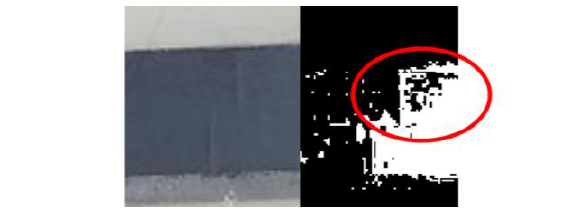
Figure 5. Result of irregular passes of the machinery (true colour image – left; binary image – right) A fact that could be confirmed in the calculated binary image (highlighted in figure 5 by a red circle). The respective pixels of that highlighted area were not detected as compacted and therefore a pixel value (0) that indicates not compacted was assigned.